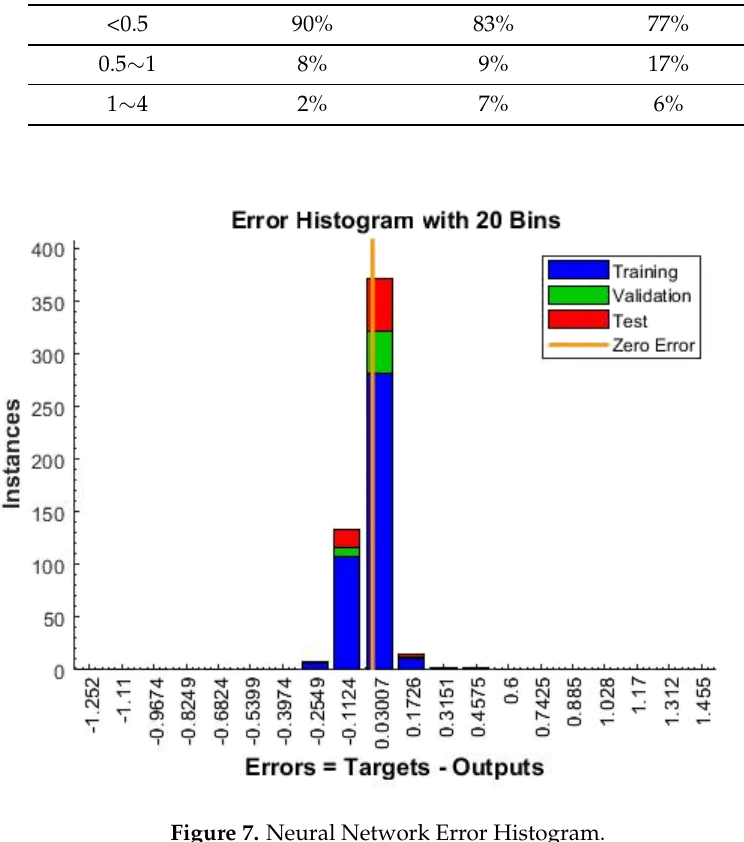
Figure 7. Neural Network Error Histogram. Table 6. Percentage error of predicted outputs in various